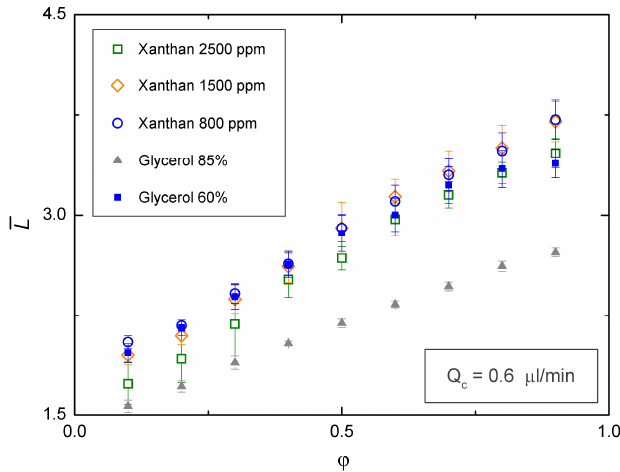
Figure 4. Dimensionless droplet length as a function of the flow rate ratio for three xanthan solutions characterized by different viscosity ratios λ with the dispersed phase (linseed oil). Xanthan 800 ppm λ = 0.3 (xanthan’s value is the shear dependent viscosity measured at θ(cid:4662) = 1 s − 1 ), xanthan 1500 ppm λ = 0.07 and xanthan 2500 ppm λ = 0.023. As a comparison, we have also plotted the data of the Newtonian solutions 60% ( w / w ) glycerol/water ( λ = 2.5) and 85% ( w / w ) glycerol/water ( λ = 0.28). The results refer to a constant flow rate of the continuous phase Q c = 0.6 μ L/min.